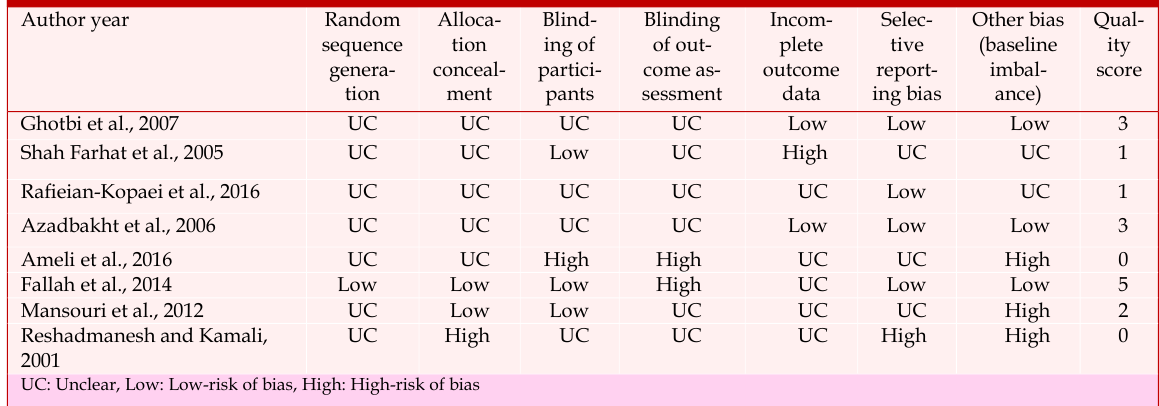
the intervention group compared to the control group and vice versa (i.e. negative values indicate the superiority of the control group). Twelve hours after the intervention, the results of the comparison of the two groups were in favor of the intervention arm, although the SMC of this measure was not statistically significant (Figure 6). Nonetheless, 24 and 36 hours after the intervention, the results of the comparison of the two groups were in favor of the intervention group and the measure was statistically significant. In addition to the significance of this combined measure, the point values of this measure showed an ascending trend 12 to 24 hours after the intervention (Figure 6), while the comparison of the two groups 48 hours after the intervention showed another reduction in this combined measure that was not significant similar to